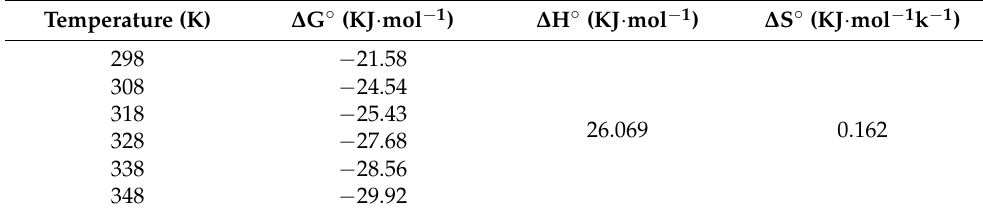
Table 3. Thermodynamic parameter for the adsorption of Cr (VI) over M-AC. Temperature